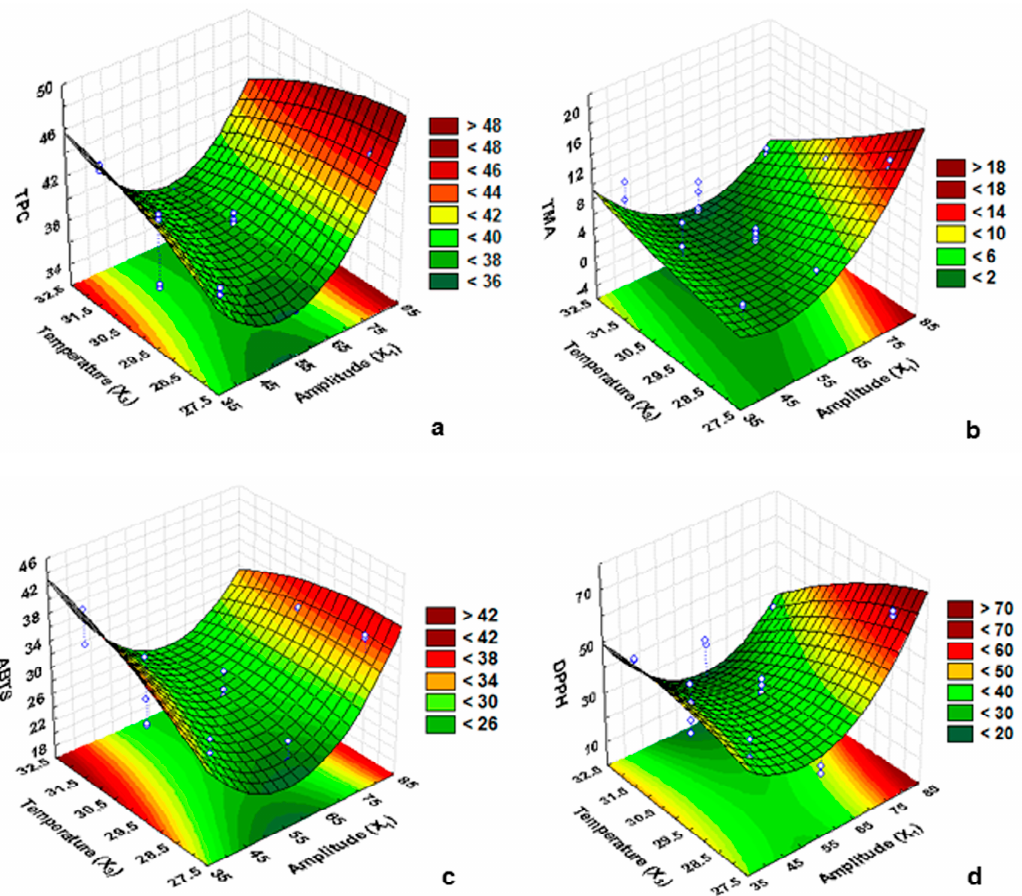
Figure 3. Response surface plot of Box–Behnken design showing the mutual effect of amplitude, time, and temperature on the yield of ( a ) total soluble phenol content (TPC); ( b ) total monomeric anthocyanin (TMA); ( c ) ABTS; and ( d ) DPPH of the leaf extract of Brosimum alicastrum .